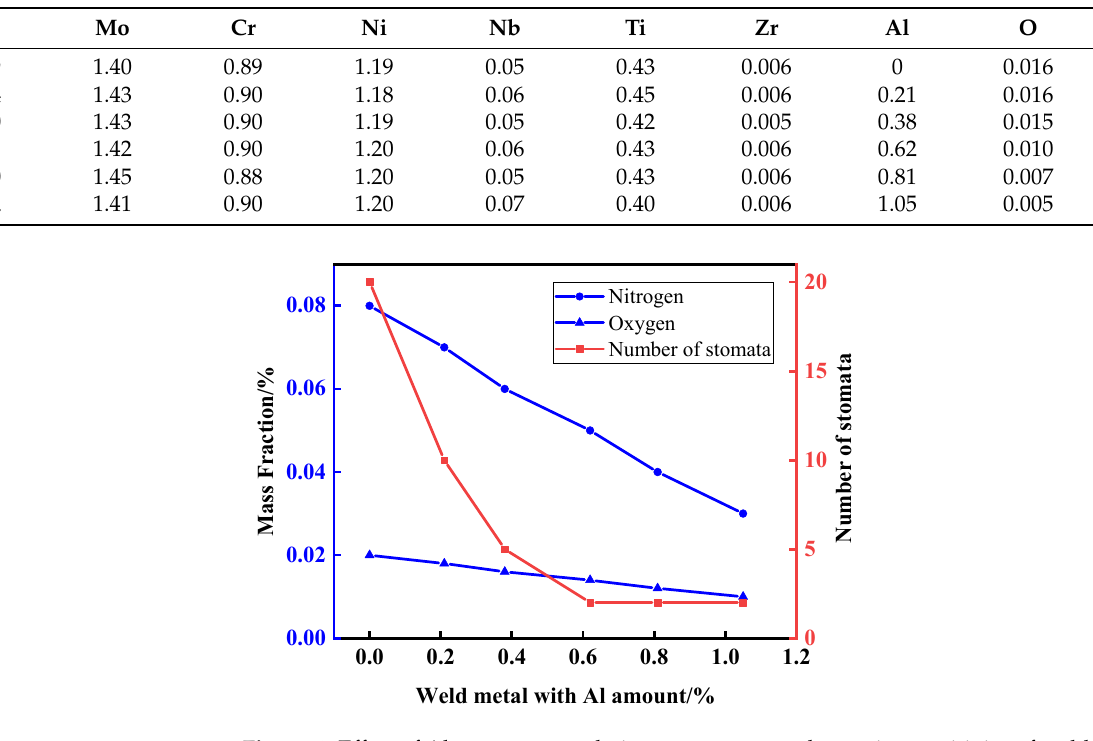
Table 4. Chemical composition of weld metal (mass, wt%).